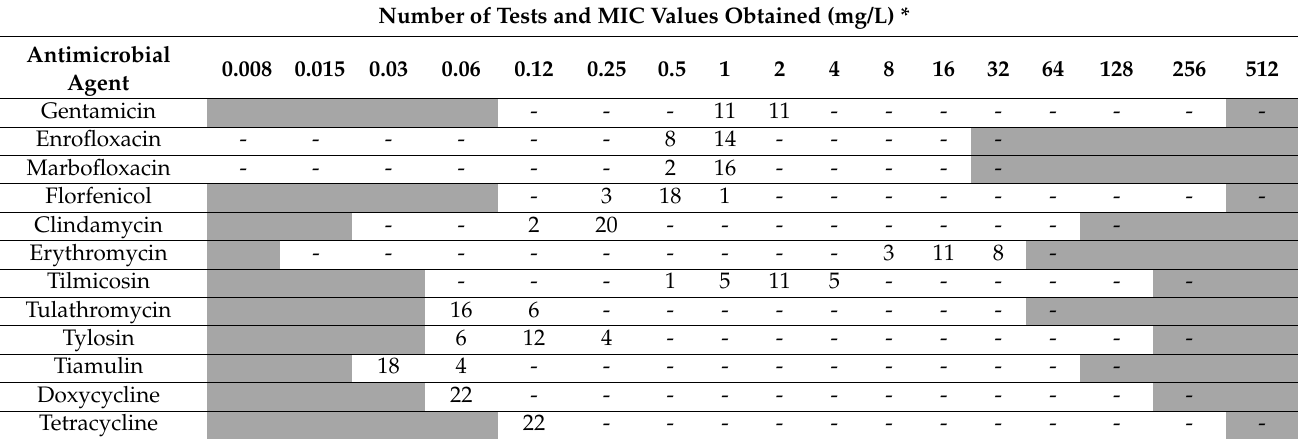
Table 2. Distribution of the MIC values of M. hyorhinis DSM 25591 obtained in 22 individual tests. Number of Tests and MIC Values Obtained (mg/L)